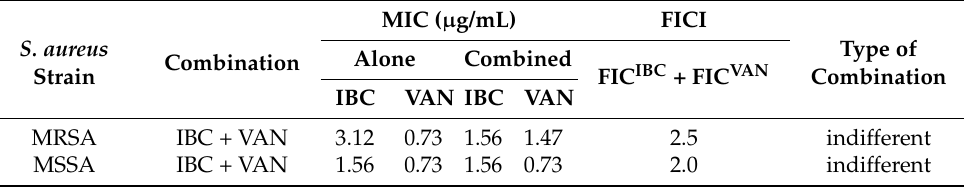
Table 2. Antibacterial effect of combination of IBC and vancomycin against MSSA and MRSA.